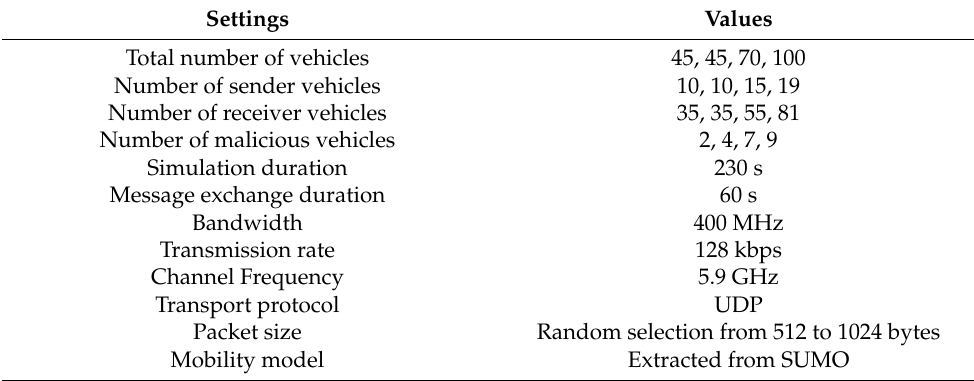
Table 2. Simulation